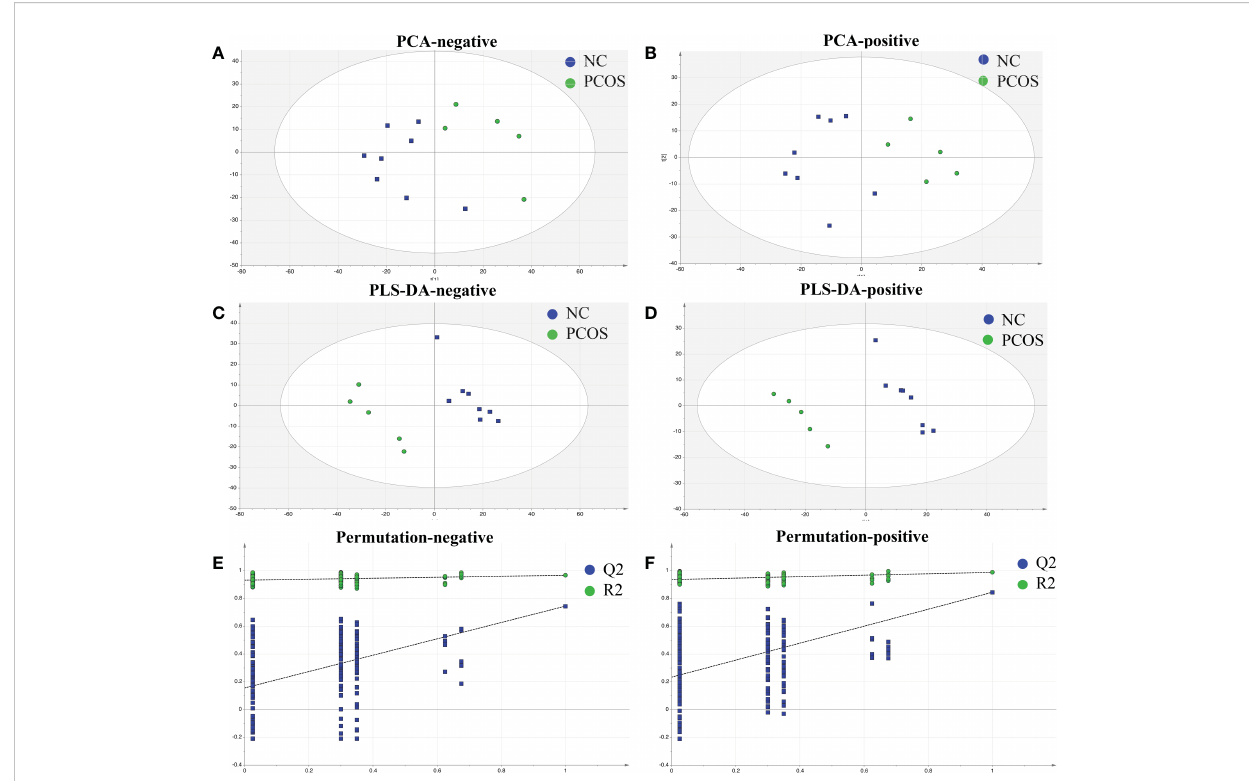
FIGURE 1 Identi fi ed metabolic pro fi le in NC and PCOS. (A, B) PCA revealed a distinct metabolic pro fi le in the PCOS group compared with the NC group. The X-axis and Y-axis represent the fi rst and second principal components, respectively. (C, D) Statistical validation with perripening analysis of the corresponding OPLS – DA model of the NC and PCOS groups. (E, F) Perripening tests were obtained from LC – MS data of the NC and PCOS groups. The intercept values of the regression line and the Y-axis are R2 and